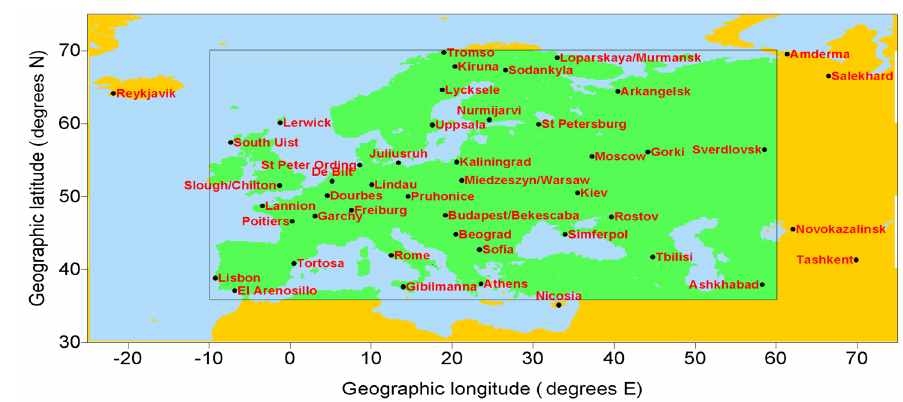
Figure 4. Map of European ionospheric vertical stations active during the IGY together to those still working.